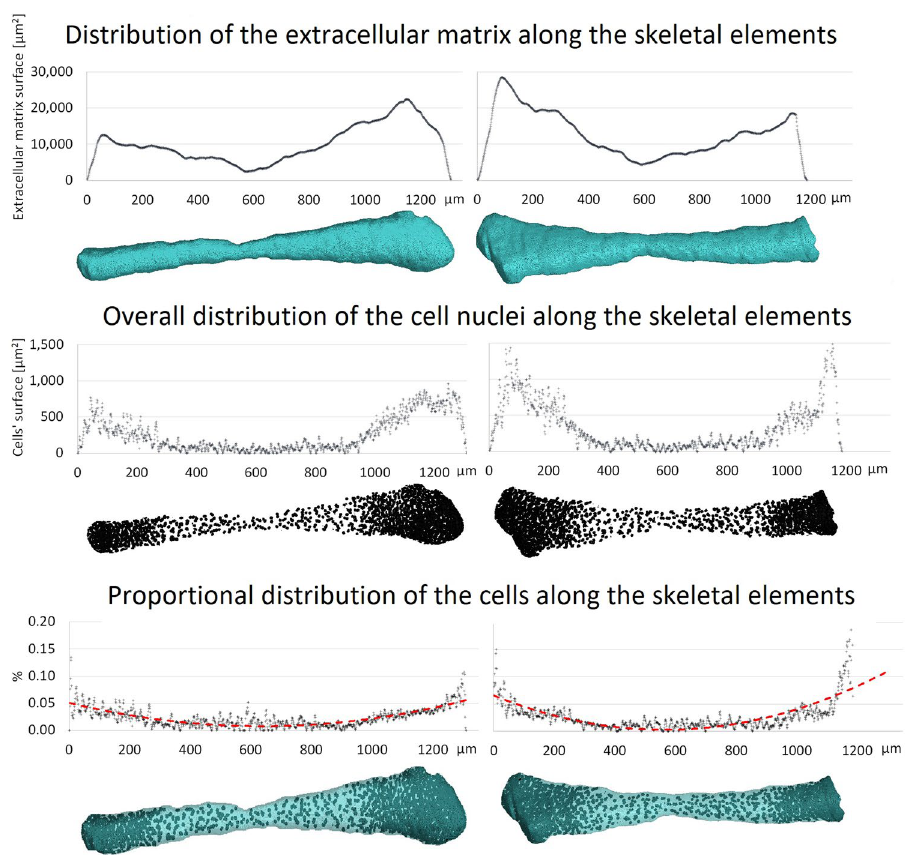
Figure 4. Distribution of extracellular matrix and cell nuclei along skeletal elements. Top: distribution of the area of extracellular matrix along the element. Middle: distribution of number of cells represented by the area of cell nuclei. Bottom: ratio between the area of cell nuclei and the area of extracellular matrix; the red-dotted line fits the data by a second order polynomial. The minimum of the parabola sits in the centre of the diaphyseal